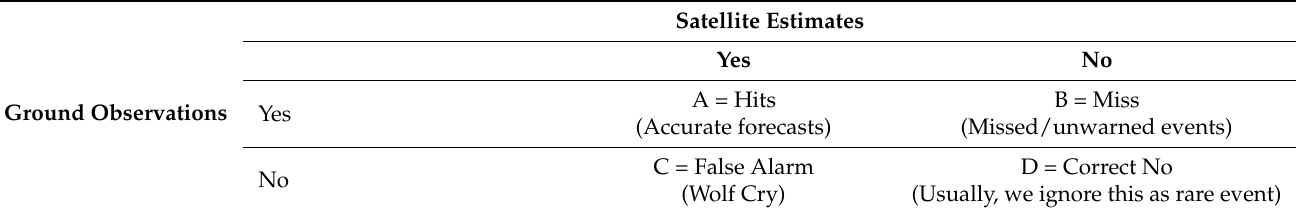
Table 2. Criteria for defining the contingency